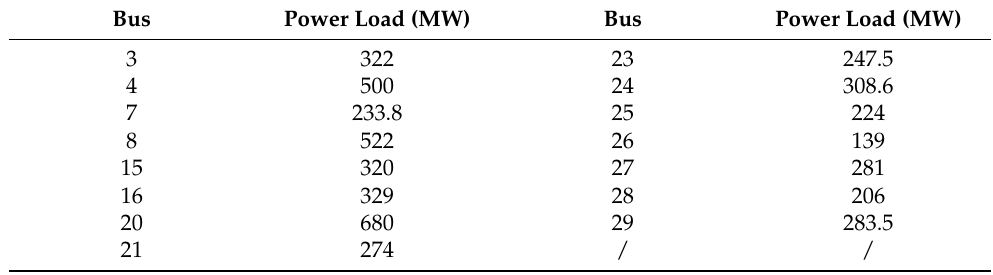
Table 2. Parameters of Power Loads.